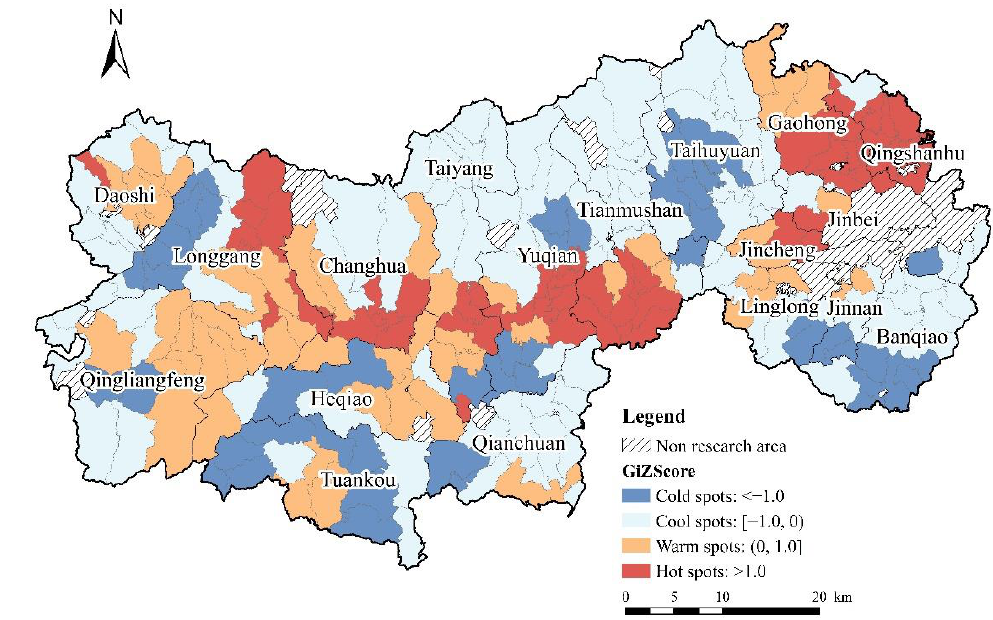
Figure 9. Distribution of hot spots of QRL in Lin’an District.